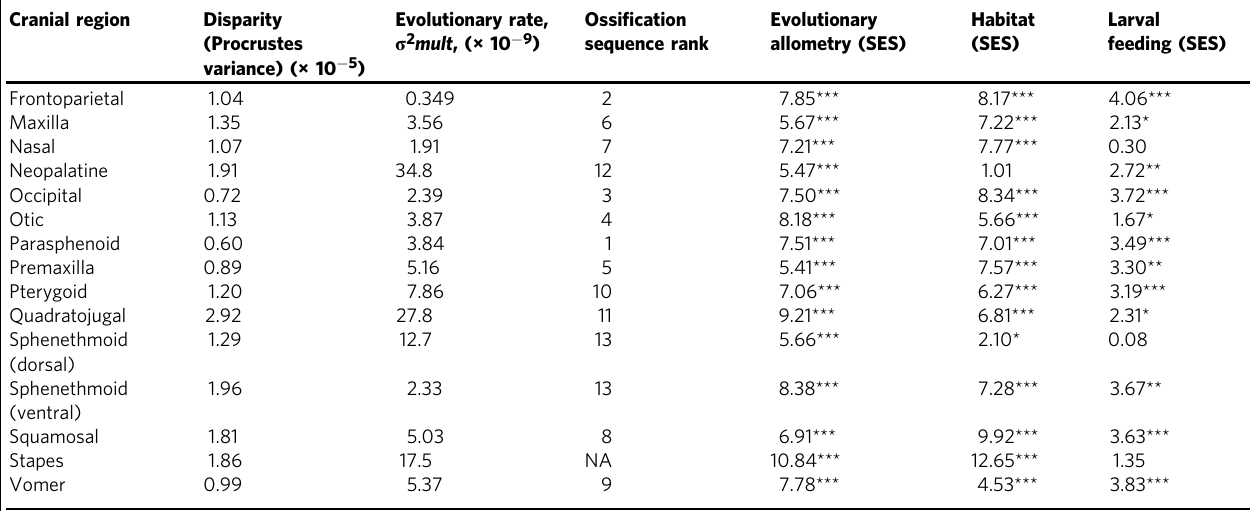
Table 1 Region-speci fi c analyses of